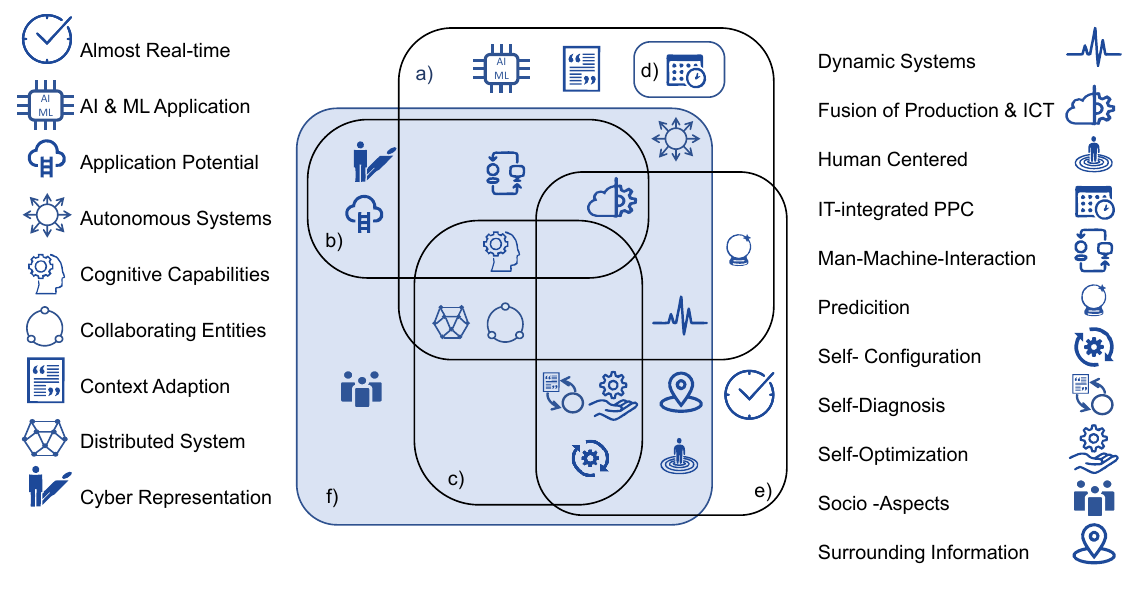
Figure 1 . Defining Aspects of CPPS – usually related but not